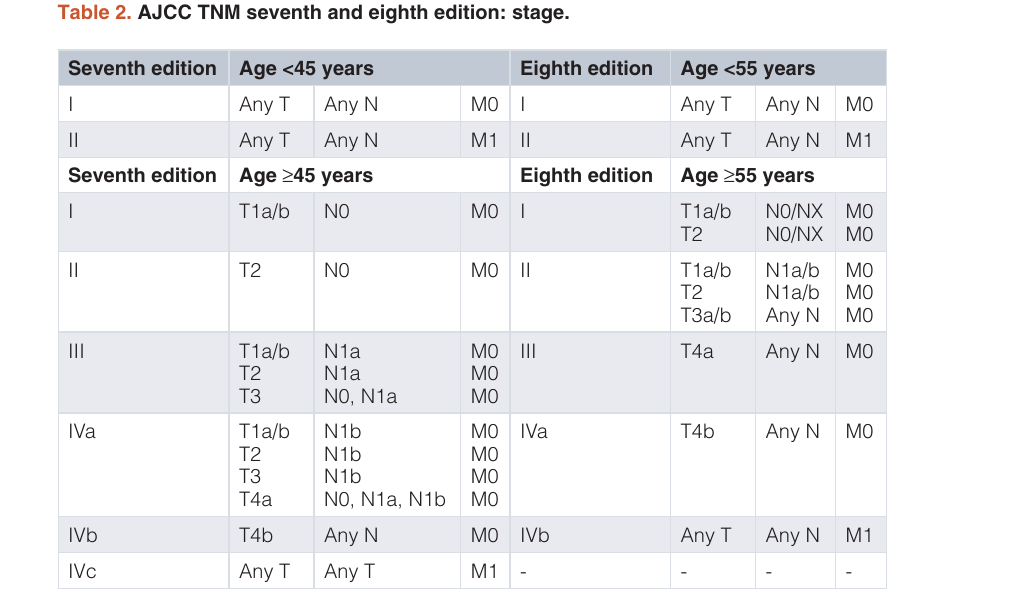
Table 2. AJCC TNM seventh and eighth edition: stage.